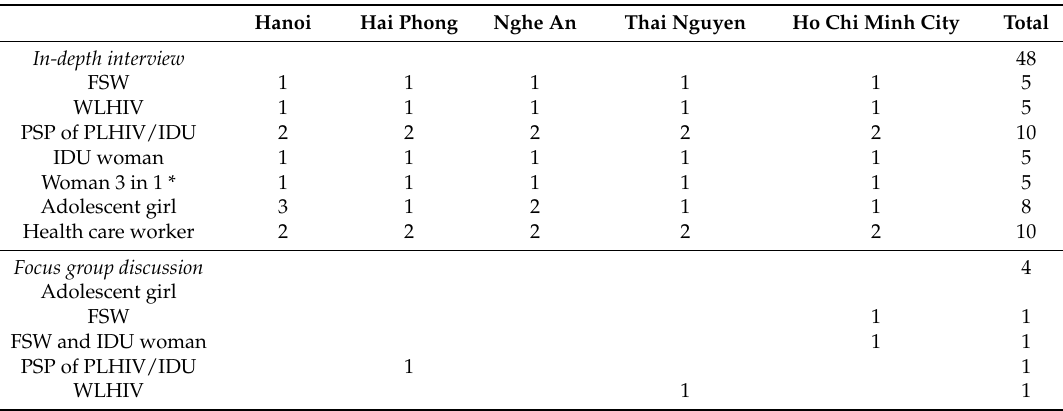
Table 3. In-depth study sample. (FSW: female sex workers; WLHIV: women living with HIV; PSP